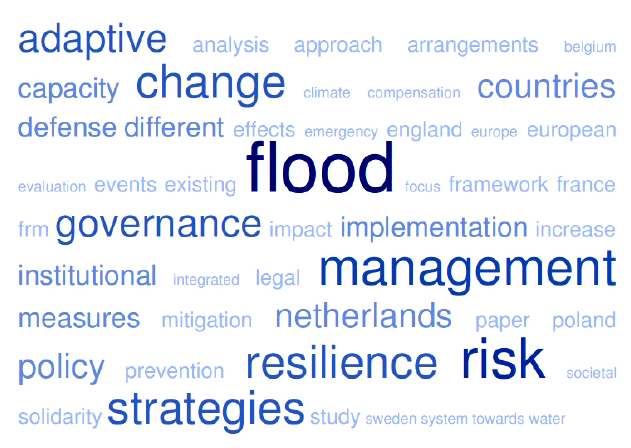
Fig. 1 . Tag cloud based on the 15 titles and abstracts in this special feature (the figure gives more prominence to words that appear more often in the